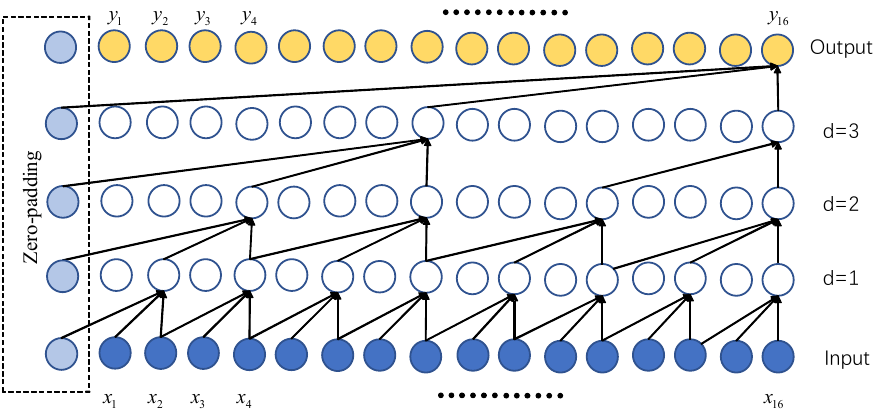
Figure 5. Schematic of dilated causal convolution.